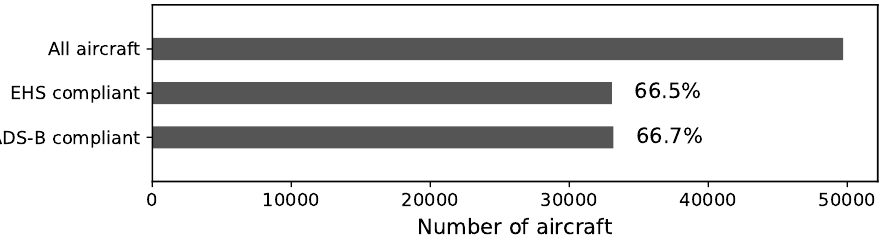
Figure 4. Aircraft that are compliant with EHS and ADS-B services.